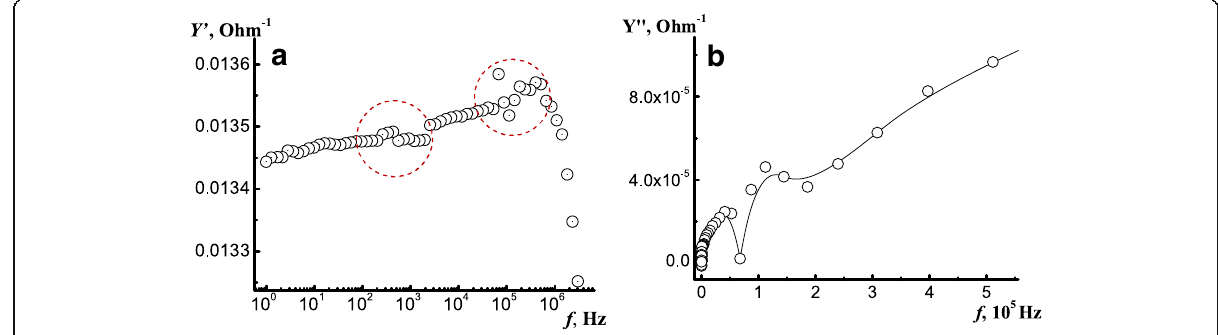
Fig. 4 Bode plots for real ( a ) and imaginary ( b ) part of admittance of MCT sample implanted with Ag +